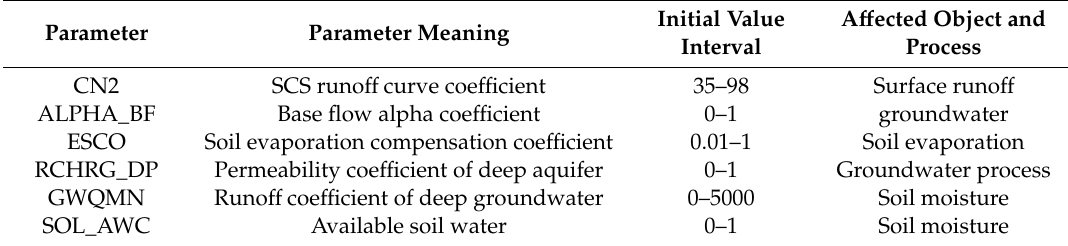
Table 1. Sensitivity parameters and value range of the Xiaoqing River